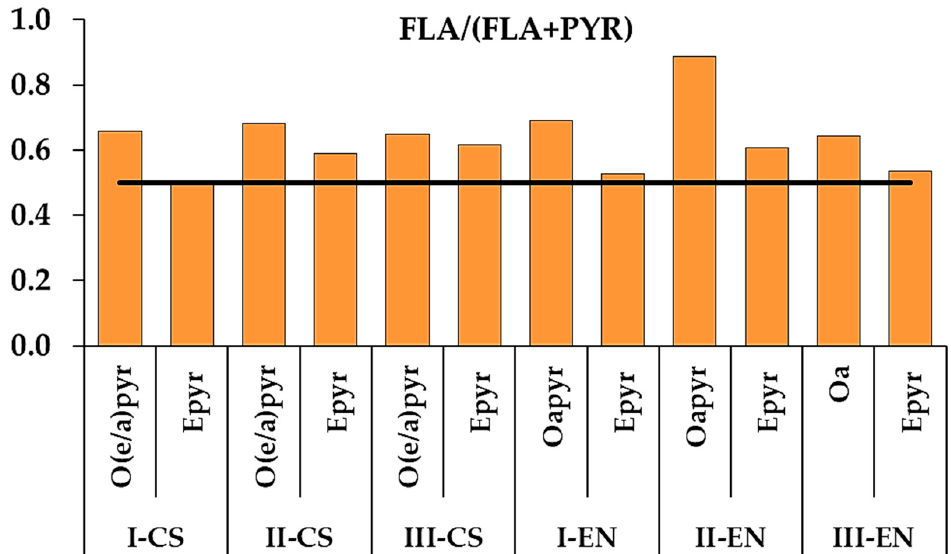
Figure 3. FLA/(FLA+PYR) ratio in the investigated pyrogenic horizons. The line marks the boundary after which (>0.5) the ratio indicates the pyrogenic origin of PAHs. EN—European North (Komi Republic); CS—Central Siberia (Krasnoyarsk region); I, II, III—site numbers.